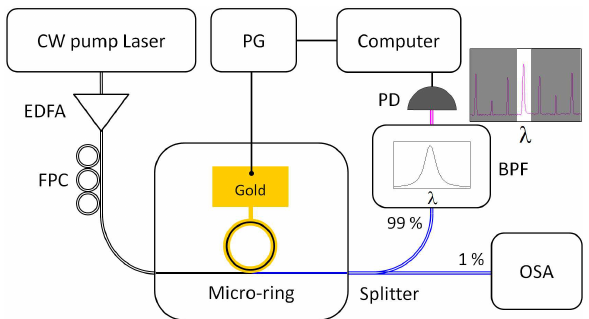
Figure 13: Experimental set up for frequency comb generation and switching. Power at PD is a filtered comb line, which is an indication of the comb on / off switching. PG: pulse generator, BPF : band pass filter. PD: photo detector.